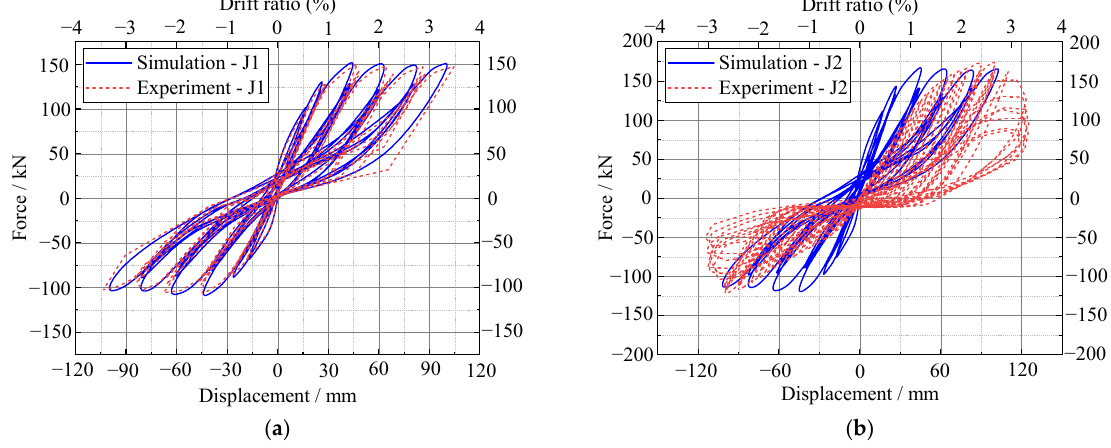
Figure 23. Comparison of experimental simulated load-displacement curves: ( a ) J1, ( b ) J2.